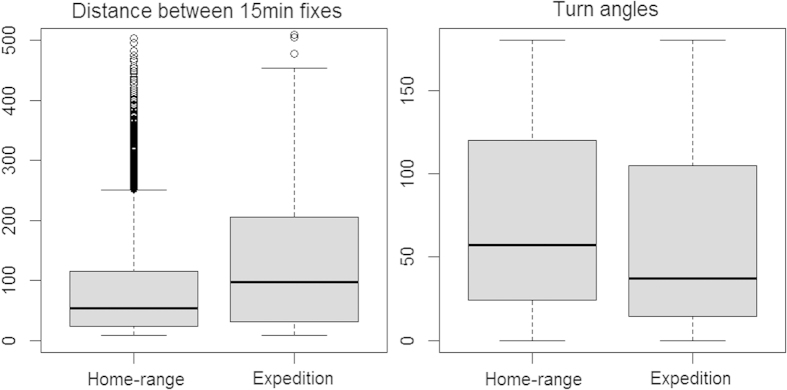
Comparison of movement parameters between 15 minute fixes within cats’ home-ranges, and during expeditions to and from an intense fire scars.Graphs were generated in R 3.1.3 (https://www.r-project.org).